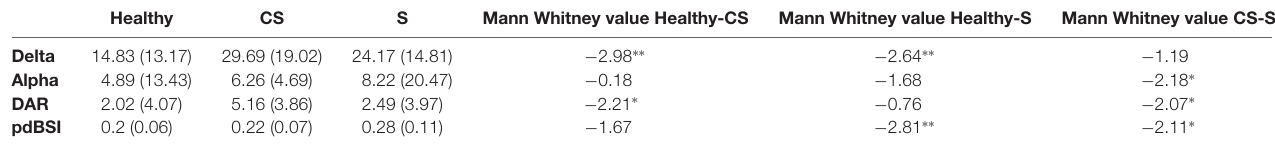
TABLE 2 | EEG power spectral density in Delta and Alpha band, Delta/Alpha Ratio (DAR) and pairwise derived Brain Symmetry Index (pdBSI) synthetic indices on the whole scalp for Healthy, CS, S patiens. Healthy CS S Mann Whitney value Healthy-CS Mann Whitney value Healthy-S Mann Whitney value